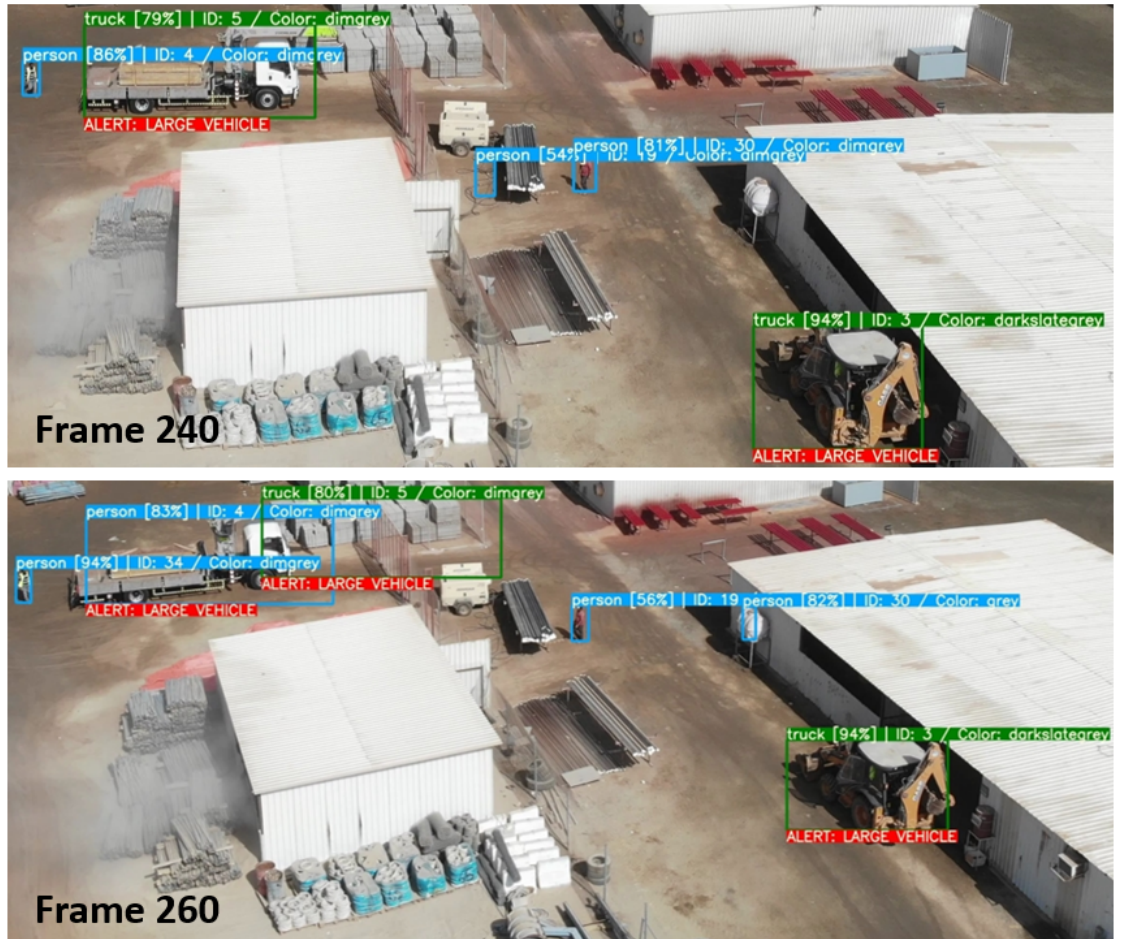
Figure 13. Sample frames from the output of video 1, showing frames number 240 and